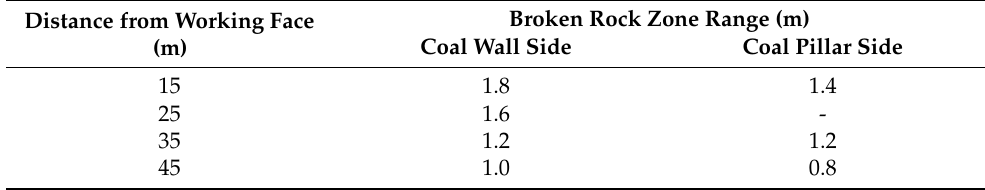
Table 2. Statistics of broken zone test results.